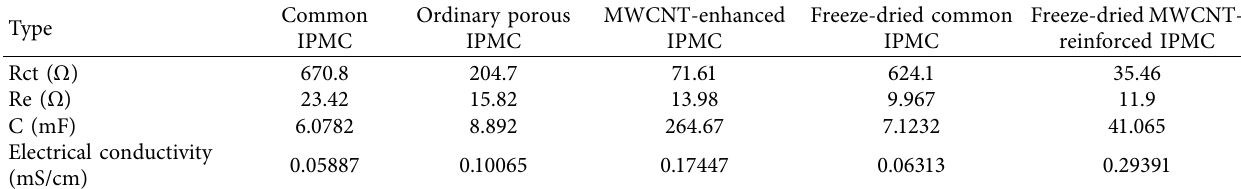
Table 1: Fitting